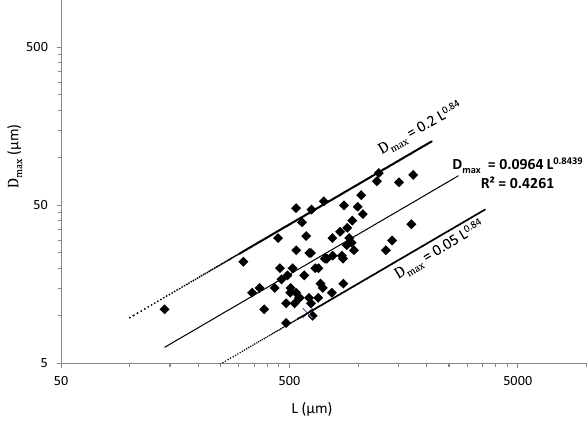
Fig. 8 The plot of cleat length ( L ) versus maximum aperture width ( D max ) for Raniganj coals with a power-law best fit trend captured by the continuous black straight line. The upper and lower dotted trend lines capture the spread of the measured